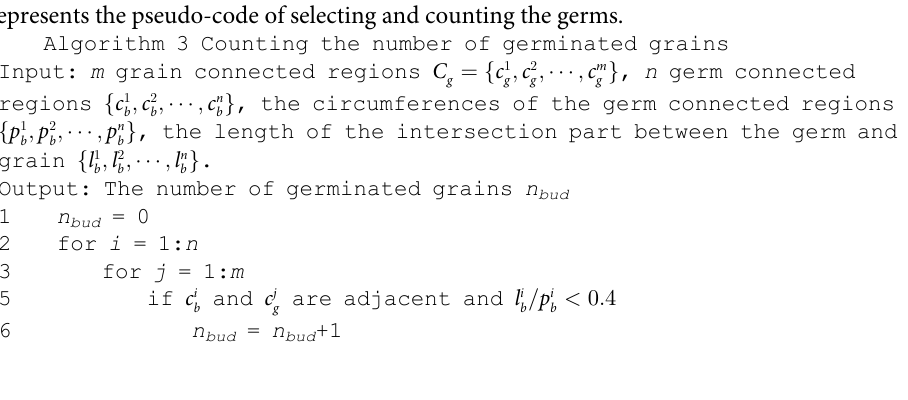
Algorithm 3 Counting the number of germinated